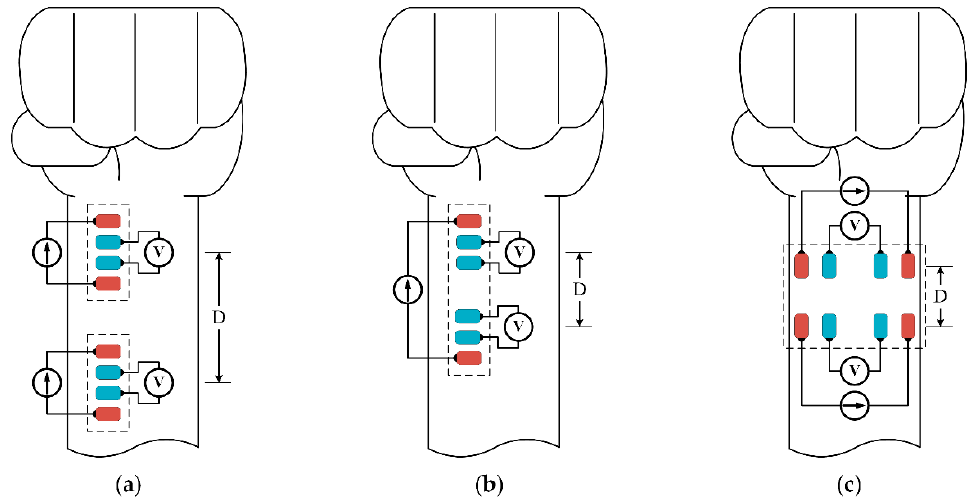
Figure 3. Distribution of electrode sites on the forearm for PWV measurement with ( a ) long distance; ( b ) short distance in the vertical direction; and ( c ) short distance in the horizontal direction.